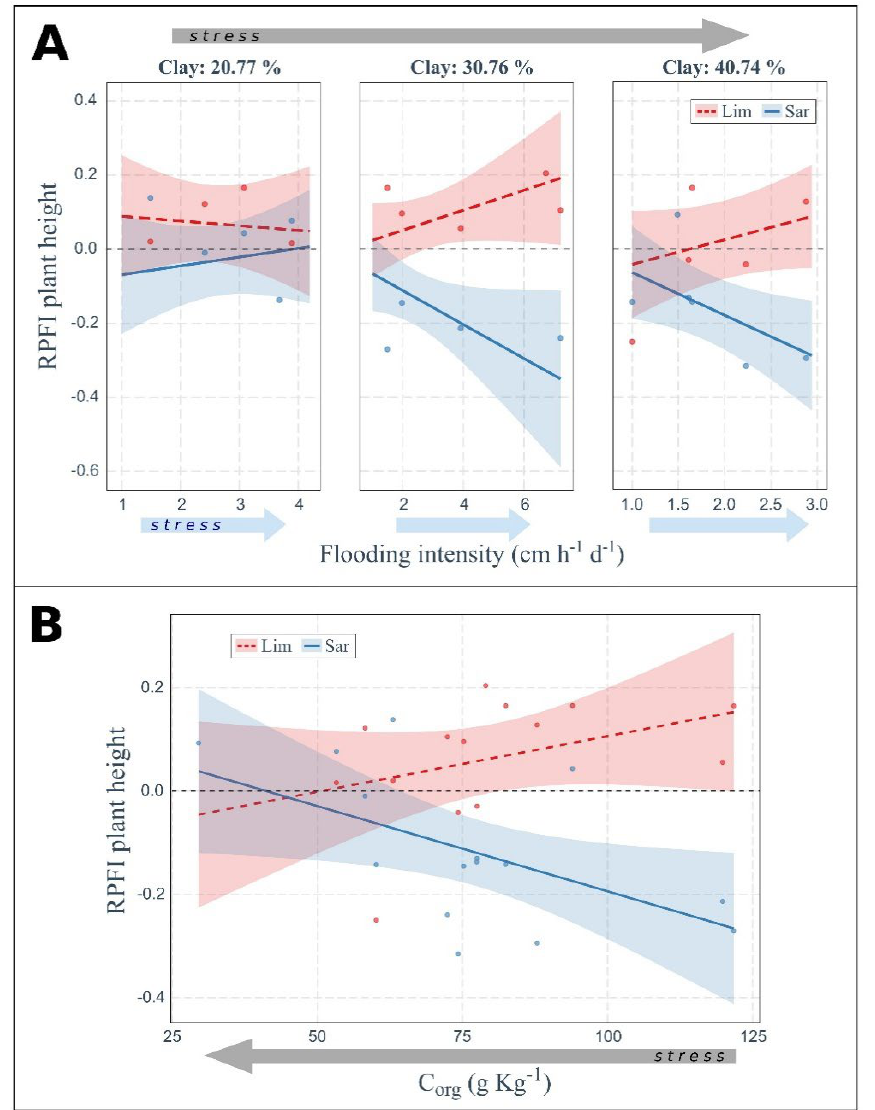
Figure 5. Combined effects of flooding intensity and soil texture and of soil organic C on plant fitness in terms of plant height. Positive values of RPFI denote larger fitness of the species when growing in plurispecific stands compared to monospecific plant communities. Arrows indicate the increasing stress gradient of flooding (light blue arrow) or of harsher soil conditions (grey arrow, i.e., increasing soil clay content ( A ) or decreasing soil organic C ( B )). Only significant relationships obtained from the ANOVA applied on linear models are shown (see Table S4, R 2 = 0.50 for ( A ); R 2 = 0.52 for ( B )). Lim or Sar labels indicate the target species Limonium narbonense or Sarcocornia fruticosa , respectively. Statistically significant differences of RPFI were found between the two species (both ( A ) and ( B )). Significant differences in slopes were found for S. fruticosa only (( A ), see Table S4).